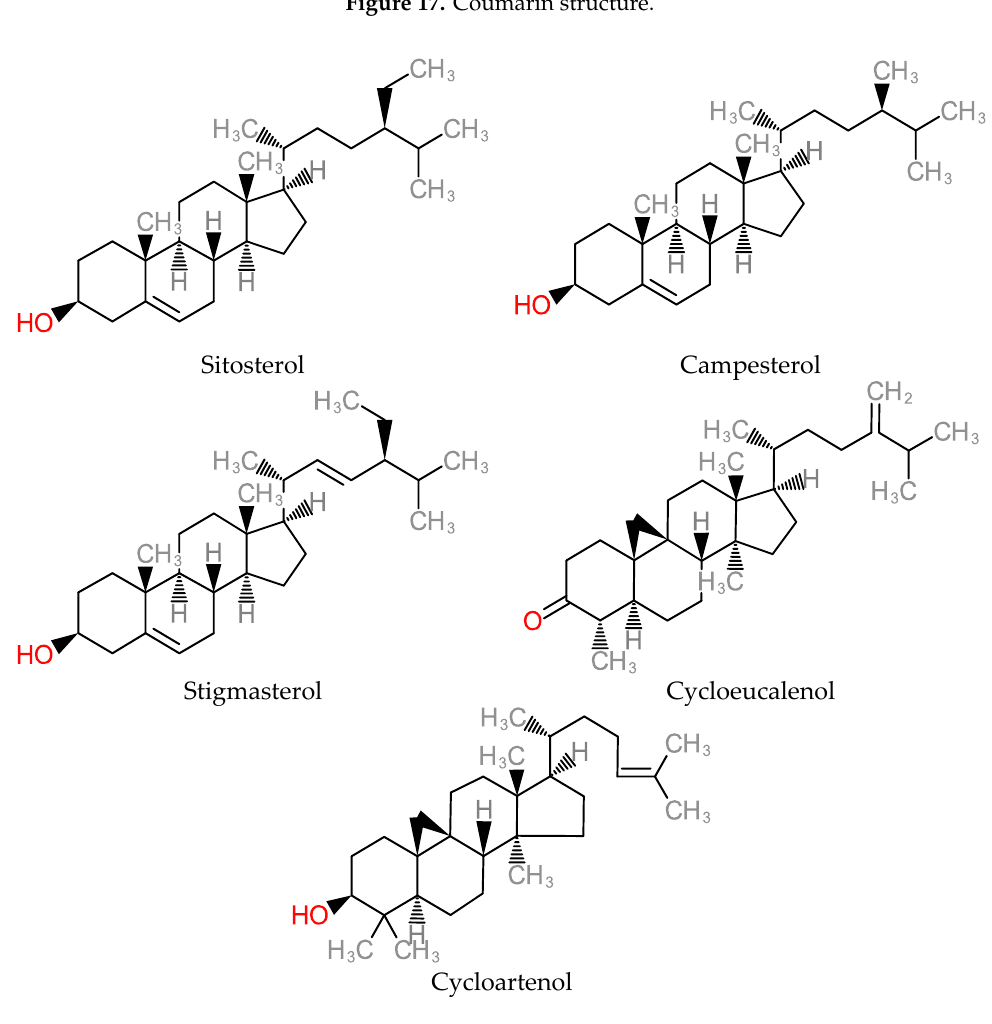
Figure 18. Structure of Phytosterols.